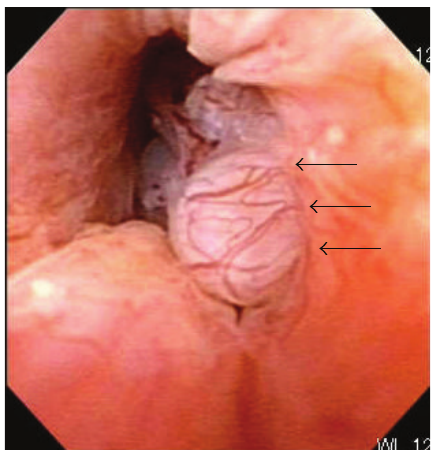
Figure 2: Cystourethroscopy before TUR. It revealed that a pap- illary tumor was in the left side of the prostatic urethra with mild inflammatory change on the mucosa (black arrows). This finding was almost the same as the findings of the figure which was pictured at the time of cystourethroscopy in the clinic he had visited at